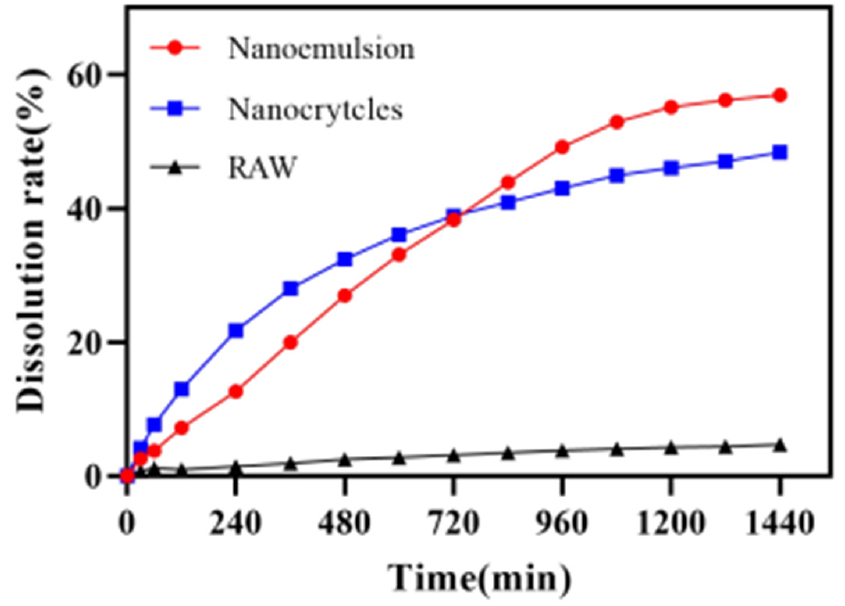
Figure 11. Release curves of the DAS samples.